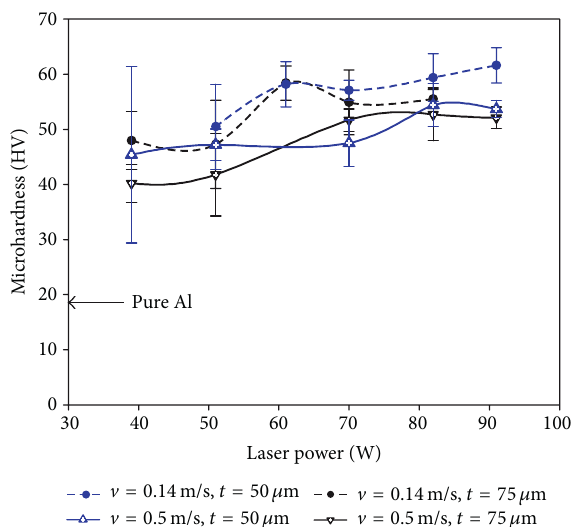
Figure 2: Microhardness of the multilayer parts fabricated with layer thicknesses of 50 𝜇 m and 75 𝜇 m and scanning speeds of 0.14m/s and 0.5 m/s versus laser